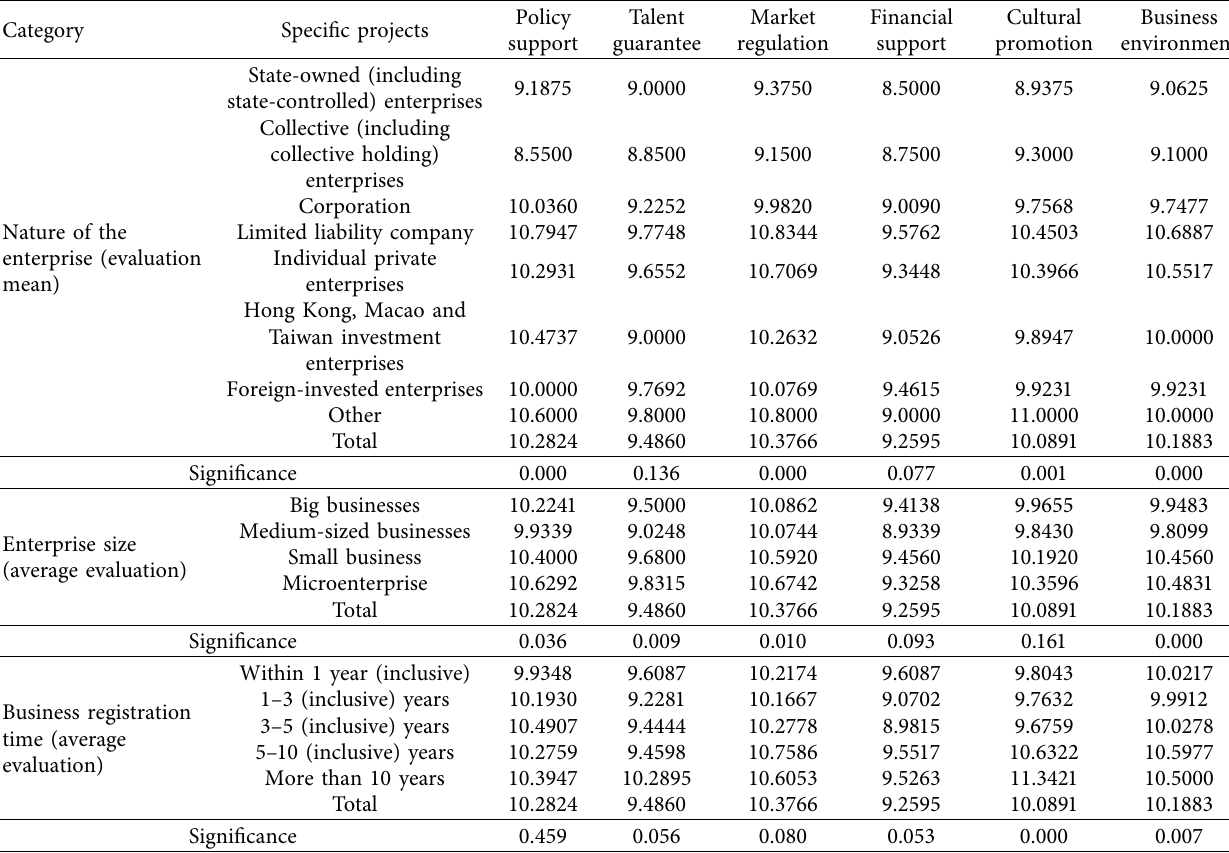
Table 5: One-factor ANOVA table of the nature of the enterprise, the size of the enterprise, and the duration of the enterprise registration. Policy Category Specific projects